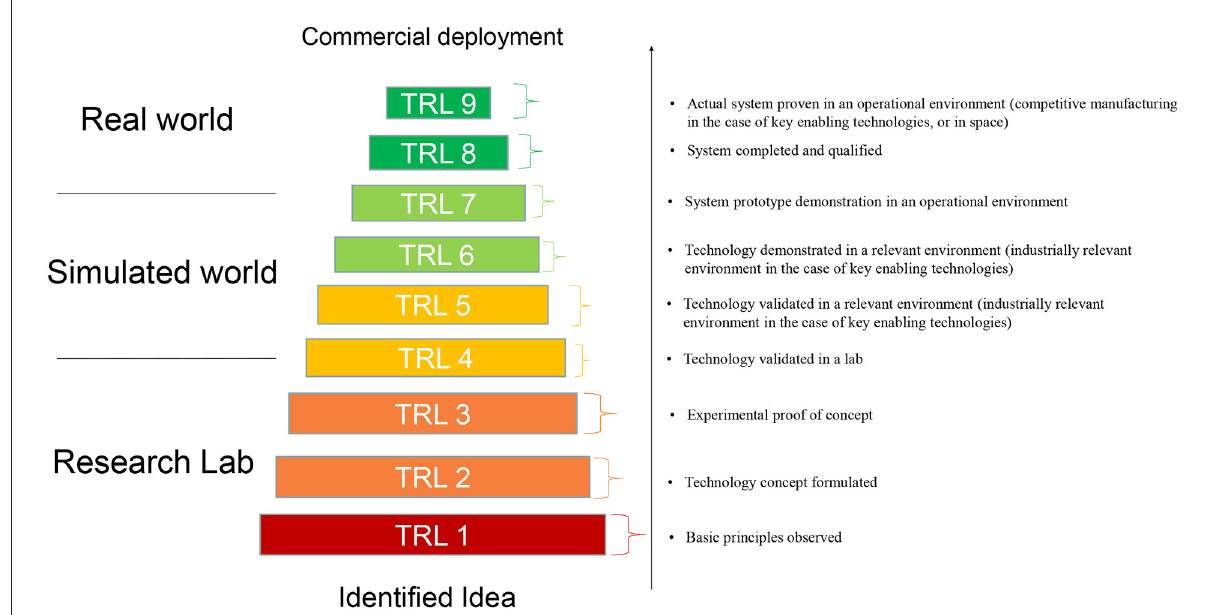
FIGURE1 Graphical representation of Technology Readiness Levels (TRLs). The TRLs as defined in the General Annexes of the Horizon Europe work program appear on the right. Graph is based on Maurelli et al.